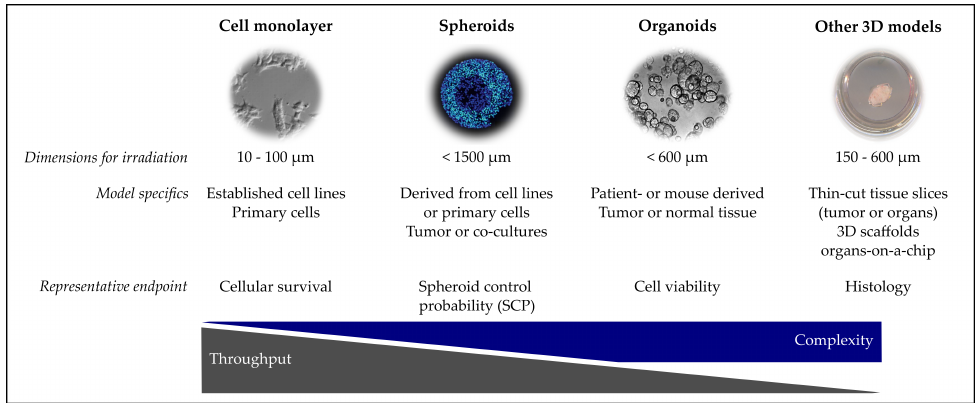
Figure 2. Overview of in vitro models for proton radiobiology experiments. Images (left to right): migrating human uveal melanoma cells [22], fluorescence staining of a tumor spheroid [72], human pancreatic cancer organoids (courtesy of Max Naumann), tumor slice culture [39]. Dimension refers to the required beam path length for irradiating the respective